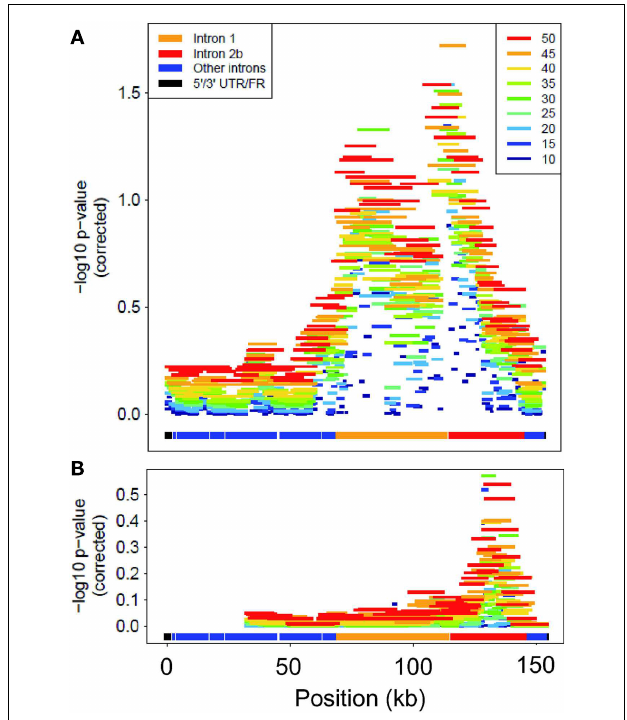
FIGURE 3 | Corrected-log10 p -value for each window in FKBP5. Colors differentiate lengths of windows for analysis of (A) all variants and (B) only rare variants. “Position” is kb from start of